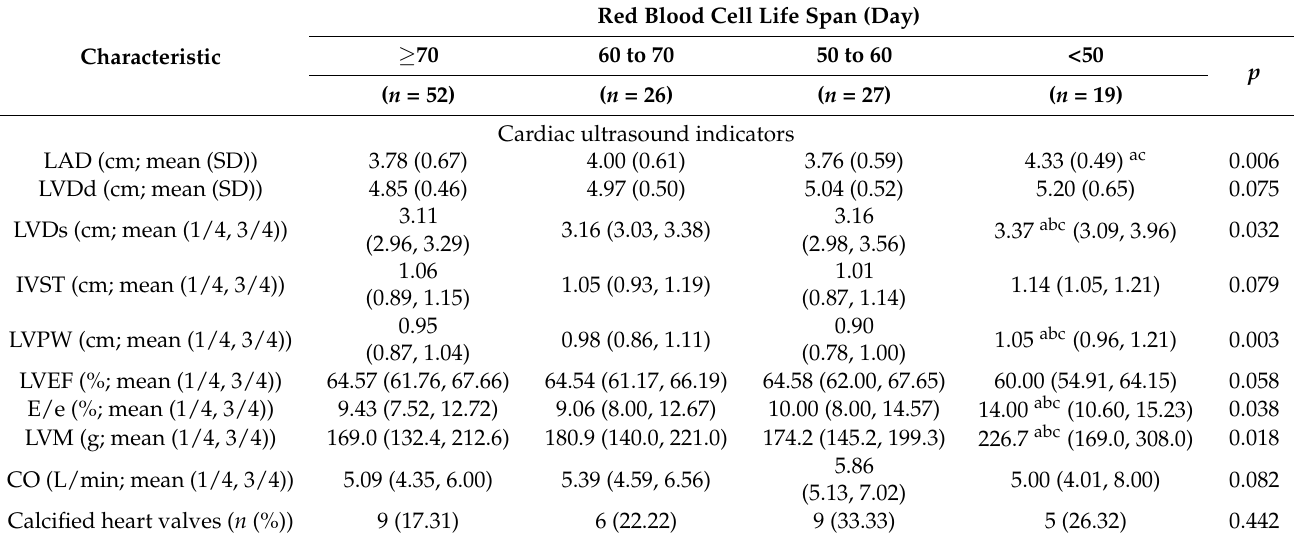
Table 2. Echocardiographic features of non-dialysis patients with CKD stages 3–5 with shortened RBCLS.